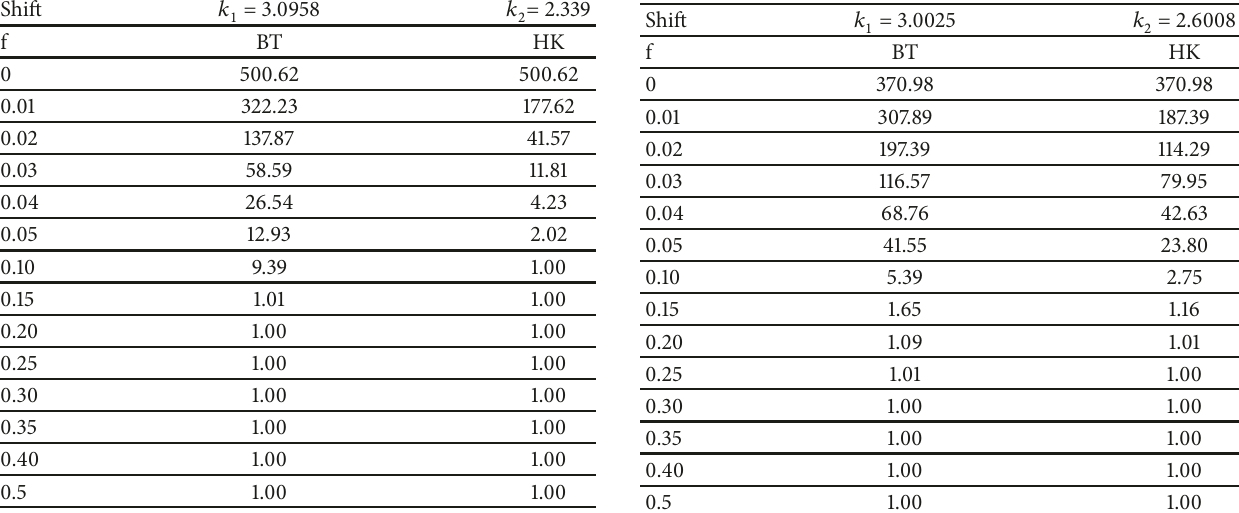
Table 15: ARLs for proposed repetitive EWMA-RSS control charts using exponential ratio-type estimators, for 𝜌 = 0.90 when 𝑟 𝑜 is 500 at 𝜆 = 0.1.